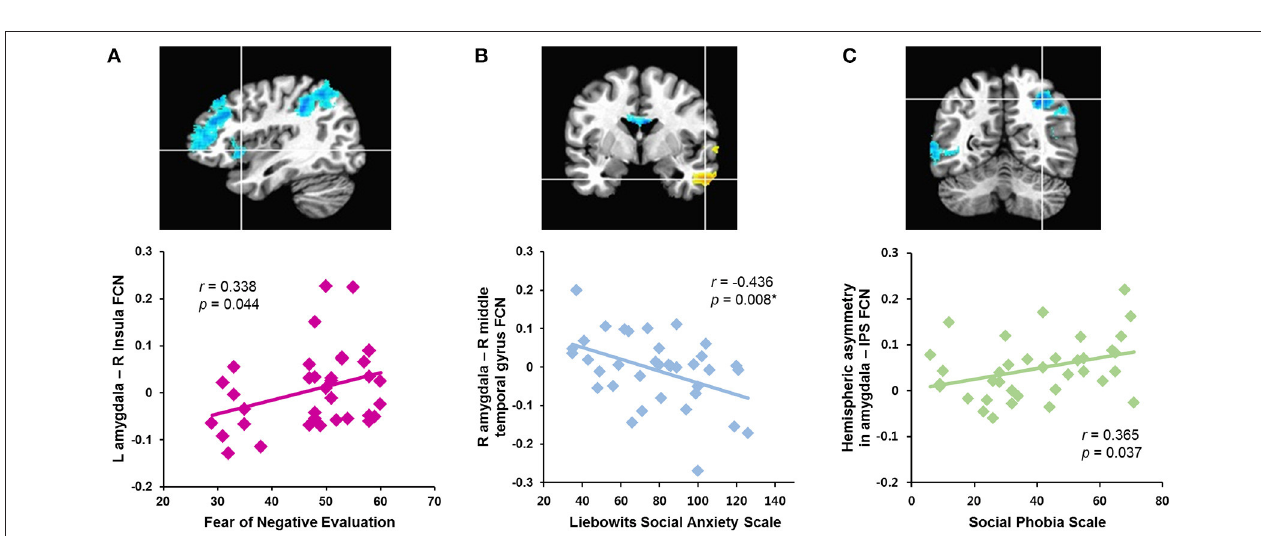
FIGURE 2 | Correlations between symptom severity and rs-FCN strength of brain regions showing between-group differences in the functional connectivity with the left and right amygdala and hemispheric asymmetry in patients with social anxiety disorder. The right insula (A) , right middle temporal gyrus (B) , right intraparietal sulcus (C) . *Significant finding after a sequential Holm-Bonferroni correction for multiple comparisons. L, left; R, right; FCN, functional connectivity; IPS, intraparietal